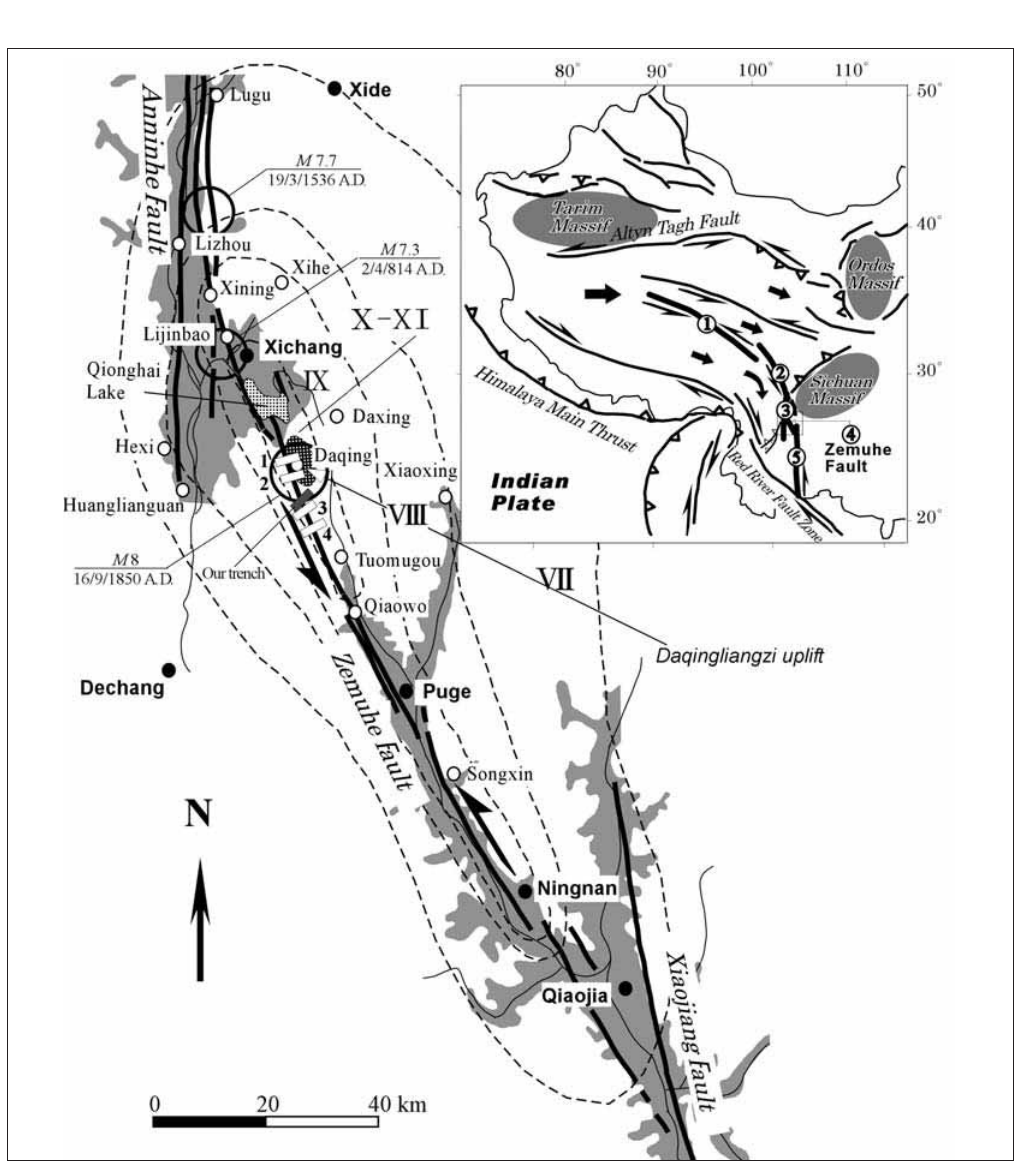
Fig. 1. Map of the Zemuhe Fault. Thick lines indicate the fault traces, large-unfilled circles are the epicenters of three historic earthquakes of M (cid:42) 7 (Gu, 1983), and the dashed ovals show the isoseismal lines of the A.D. 1850 earthquake (Ren and Li, 1993). The unfilled rectangles across the Zemuhe Fault with numbers indicate the trench locations excavated by Fen et al. (1995), while the filled rectangle indicates the location of our trench. Inset box shows the sketch of Tibetan tectonics and the Zemuhe Fault Zone location. Thick line is the Kangding Fault System: 1) Ganzi Fault; 2) Xianshuihe Fault; 3) Anninghe Fault; 4) Zemuhe Fault and 5) Xiaojiang Fault. Wide arrows indicate the movement directions of crustal blocks within the Tibetan plateau, while thin arrows show the slip of faults. Data come from Li